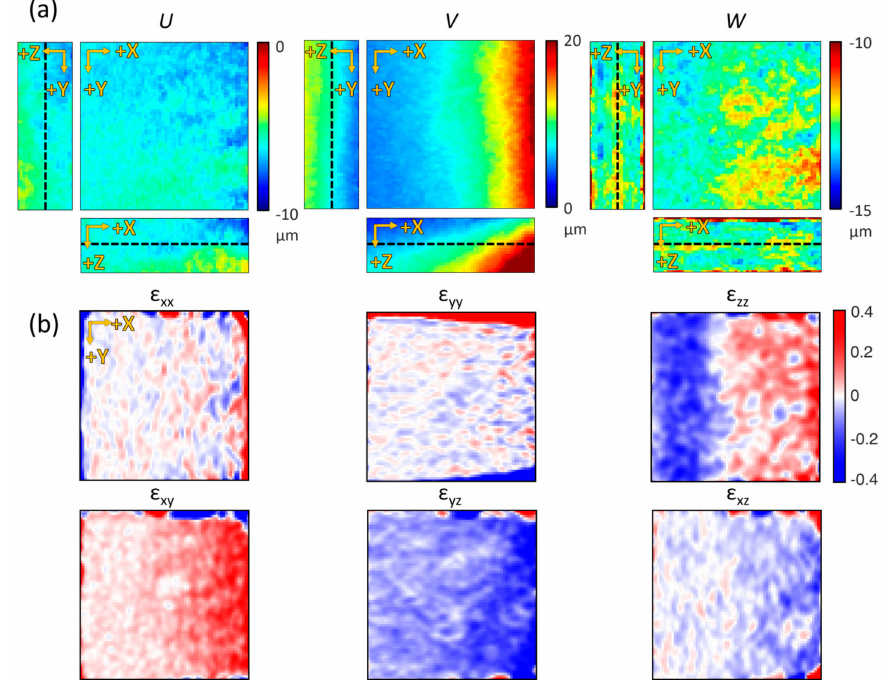
Figure 5. Displacement maps in each axis and their corresponding strain maps. ( a ) U, V, and W displacement map sliced along its center of volume. ( b ) Corresponding local strain maps. The selected Z-depth is the median of the axial field of view (indicated as black dashed lines in ( a )) (all fields of view are 224 × 224 × 130 µ m 3